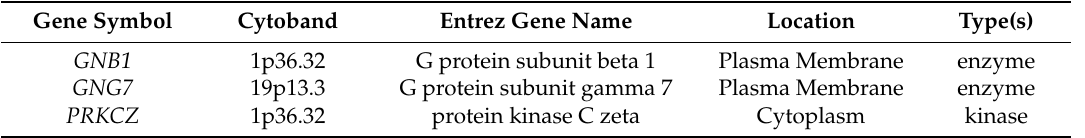
Table 3. Three genes involved in ADR signaling